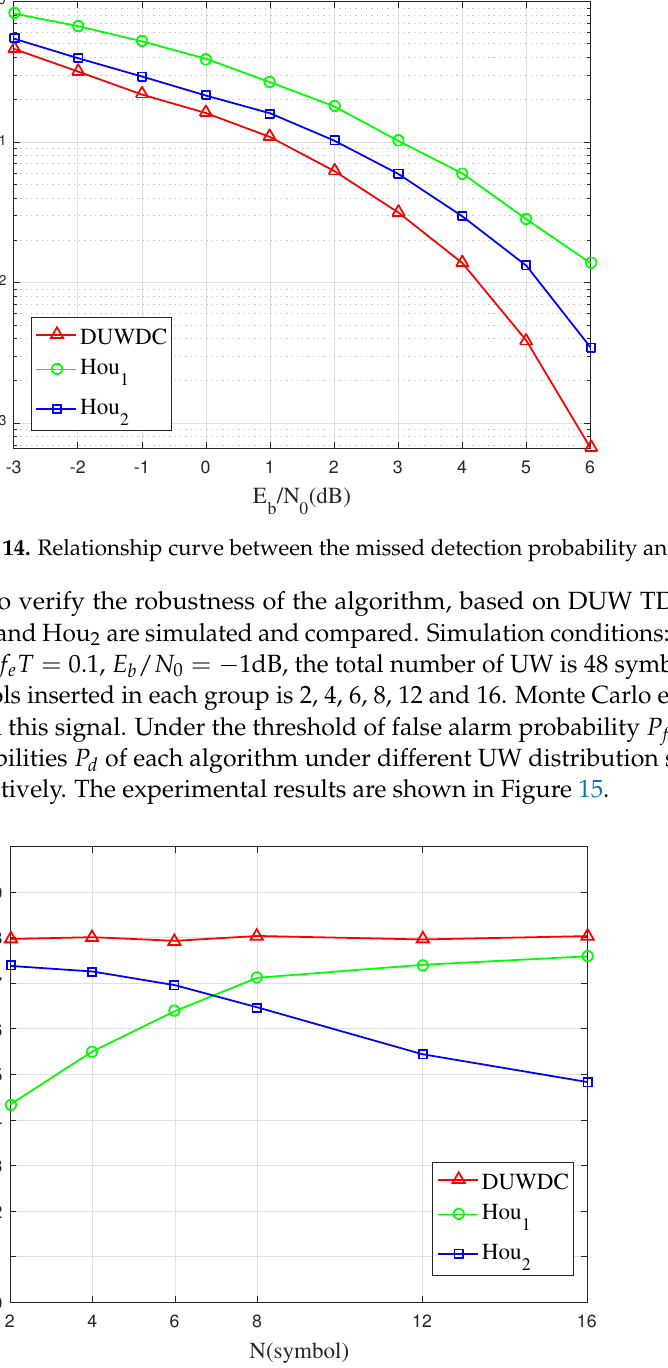
Figure 15. Influence of different UW distribution structures on algorithm detection performance. It can be seen from Figure 15 that under the same SNR, detection probability of DUWDC is at the same level for DUWs with different distribution structures, while